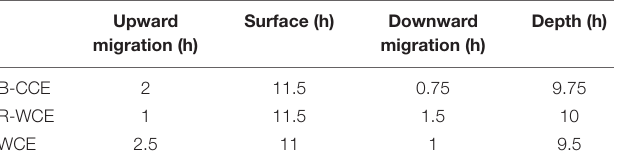
TABLE 1 | Hours micronekton spent migrating upward, staying at the surface (night), migrating downward and staying at depth (day), and during diel vertical migrations derived from